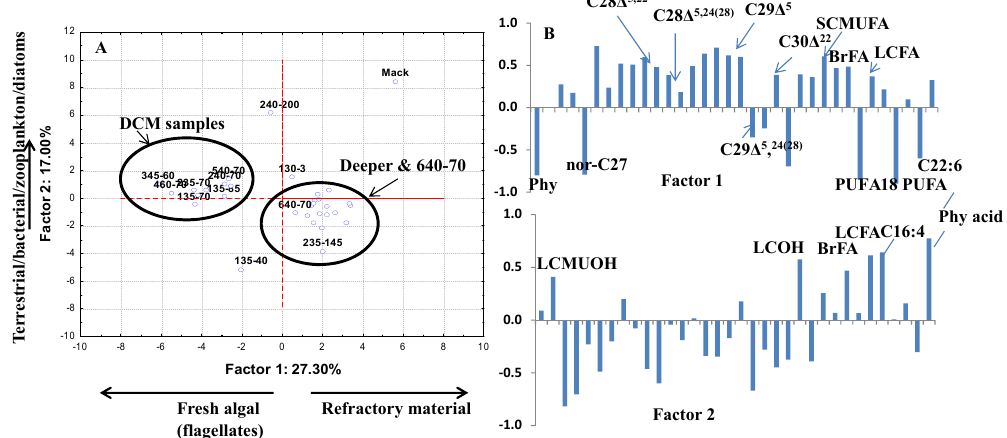
Fig. 2. Principal component score plot for each suspended particulate matter sample (A) , showing 44% of the variance and (B) factor loadings for the variables.